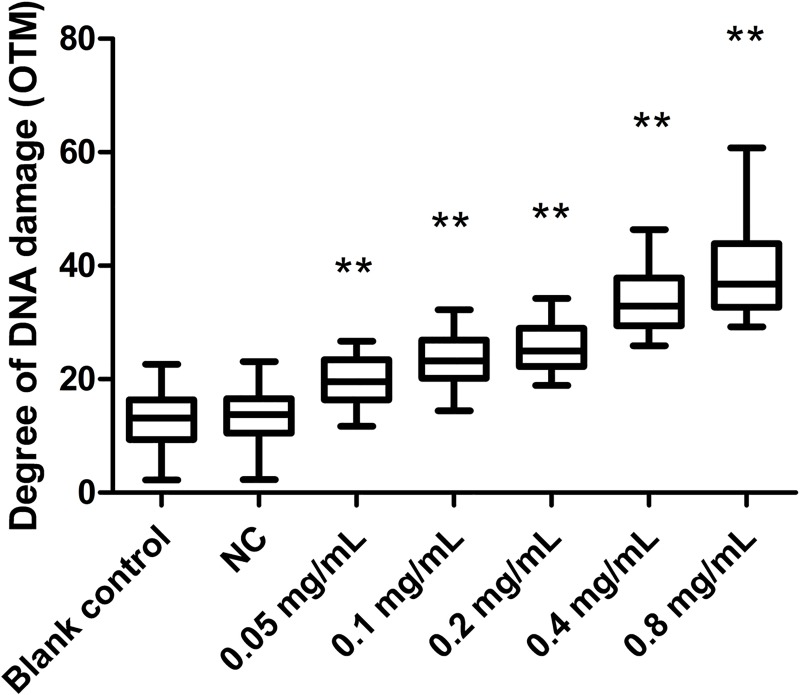
DNA damage in T. thermophila exposed to increasing concentrations of koumine for 24 h.Olive tail moment (OTM) values were measured using Comet Assay Software (CASP 1.2.3 beta 1). Data were expressed as mean ± SD (n = 3). * indicates significant differences (P < 0.05), ** indicates highly significant differences (P < 0.01). All the treatment groups were compared to the NC group.